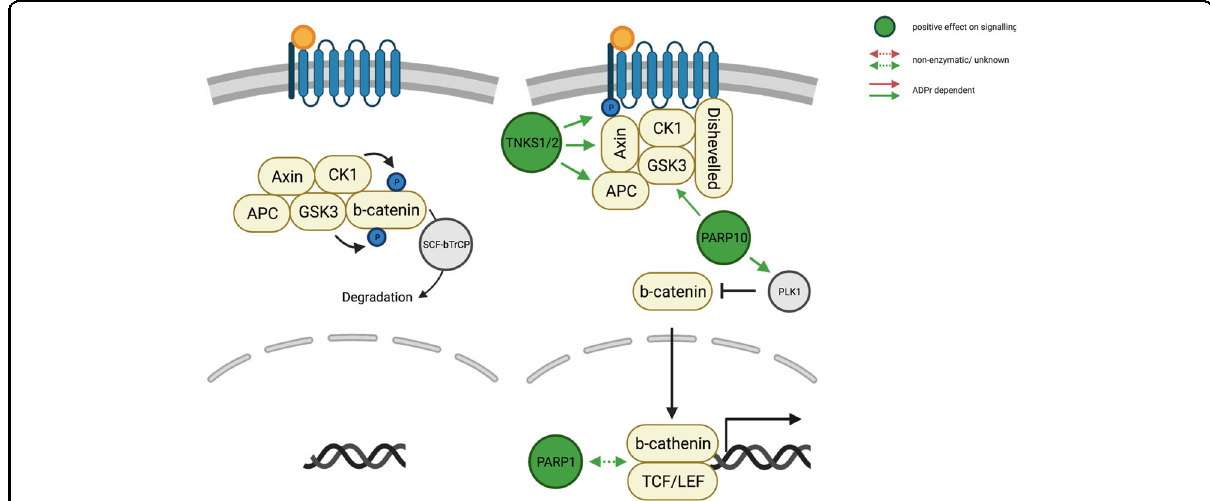
Fig. 3 Schematic overview of the interplay between Wnt/ β -catenin signaling and ARTD family members. Uninduced (left panel) and induced (right panel) Wnt/ β -catenin signaling. Positive regulations of Wnt/ β -catenin signaling by ARTD family members are depicted in green. Solid lines indicate the contribution of ADP-ribosylation to the regulation of Wnt/ β -catenin signaling. In case the contribution of ADP-ribosylation was not described or the protein itself rather than its enzymatic activity is involved in the regulation, the interactions are represented by dashed lines. (TNKS1/ 2,